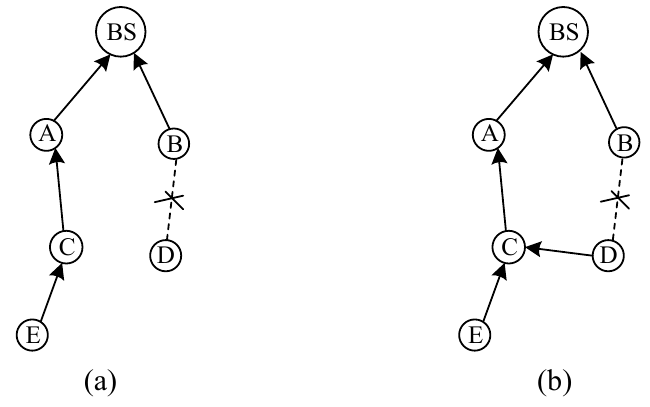
Figure 5. Declining of link quality triggers routing